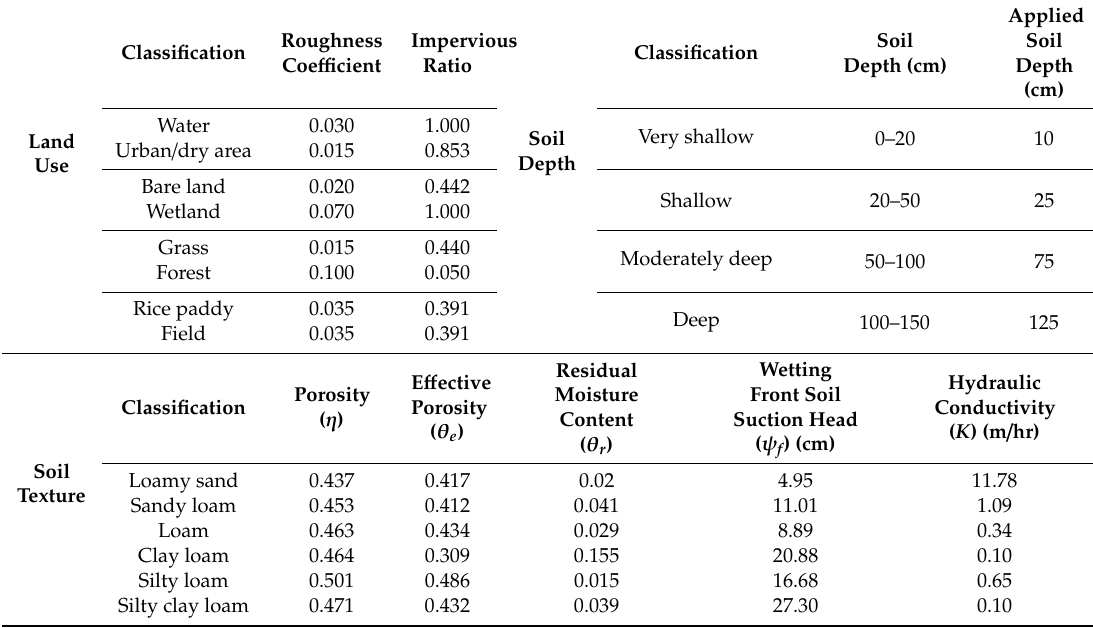
Table 1. Roughness coe ffi cients for land use, soil depth, and soil texture geographical features.